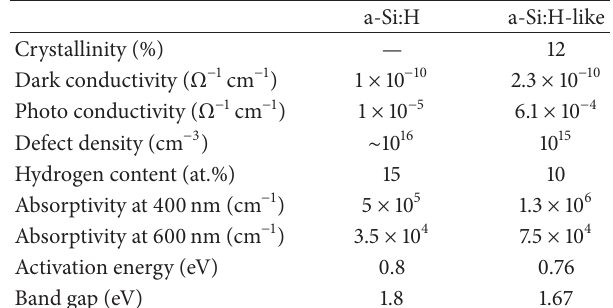
Table 1: Deposition conditions of the intrinsic and doped a-Si:H- like layers.